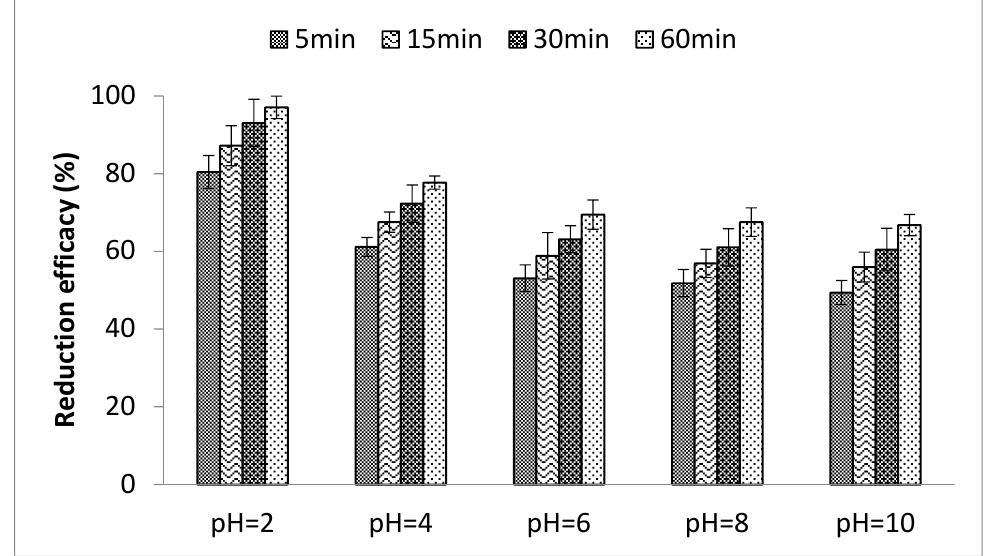
Figure 2. Effects of pH: [Cr(VI)] 0 = 10 mg·L − 1 , Cr(VI) volume = 25 mL, contact time = 60 min, pH = 2–10, PLE quantity = 1.5 mL.